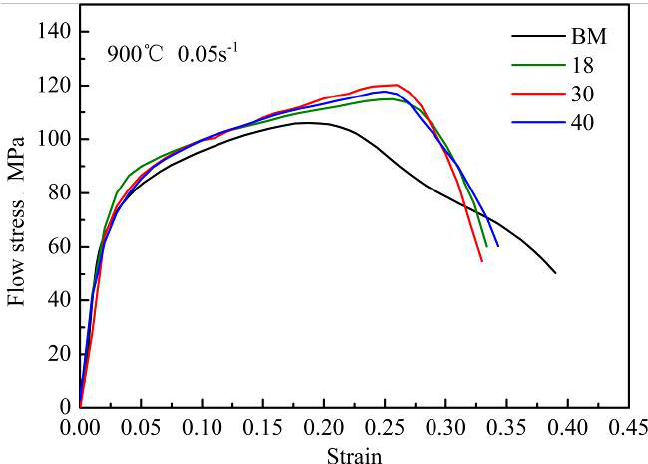
Figure 15. Flow stress-strain curves of the FZ and BM.